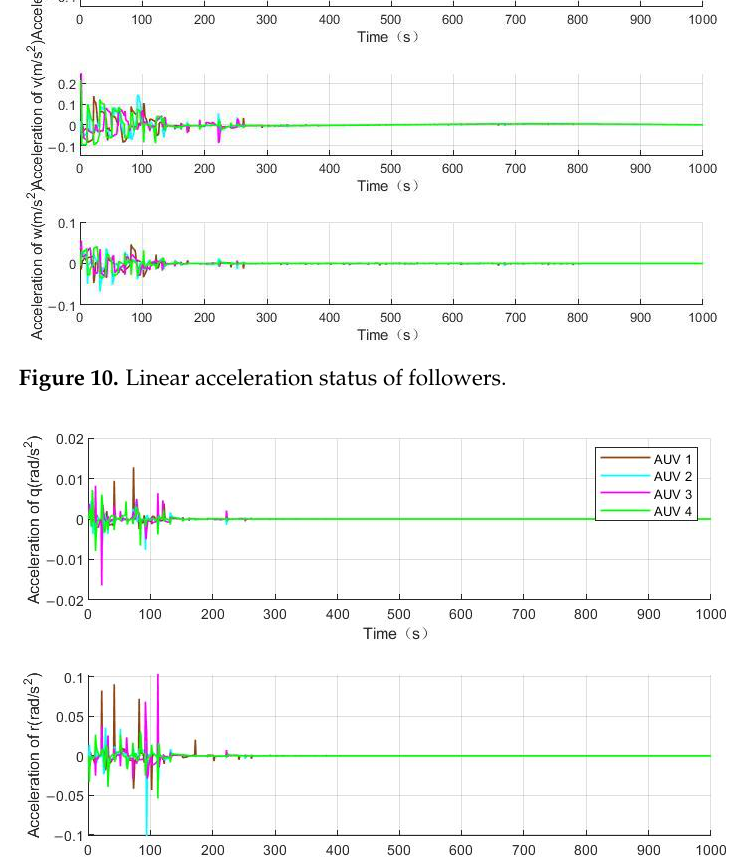
Figure 11. Angular acceleration status of followers.